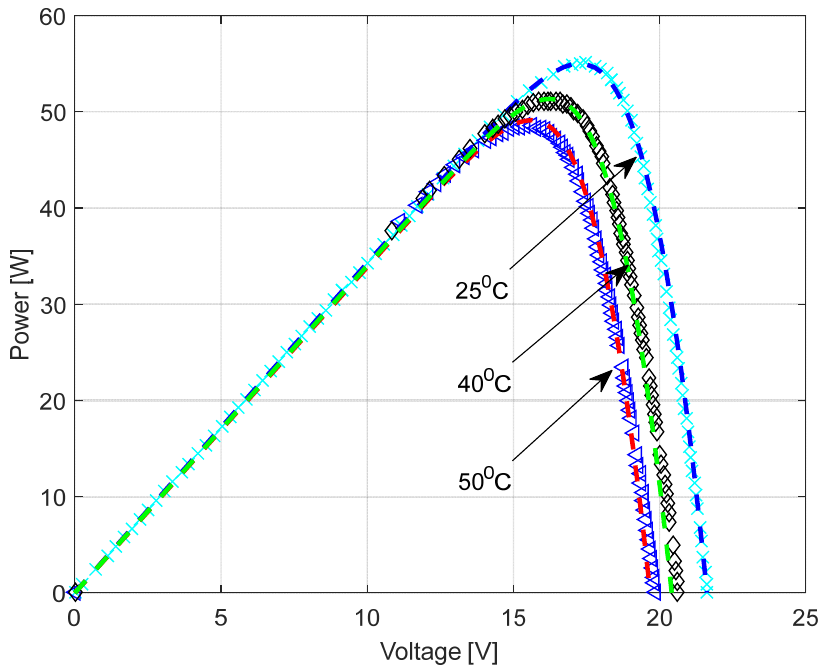
Figure 19. Power-voltage characteristics at 1000 W/m 2 for different temperature levels. Table 9. The estimated value of the parameters of the commercial solar module.